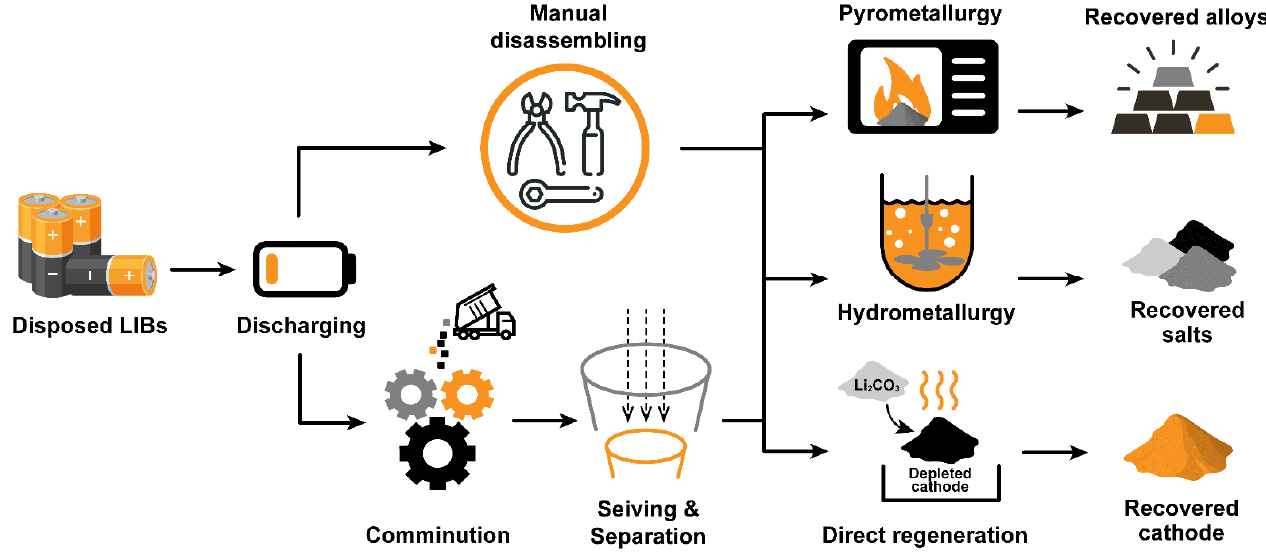
Figure 5. General scheme of LIB cathode recycling routes.